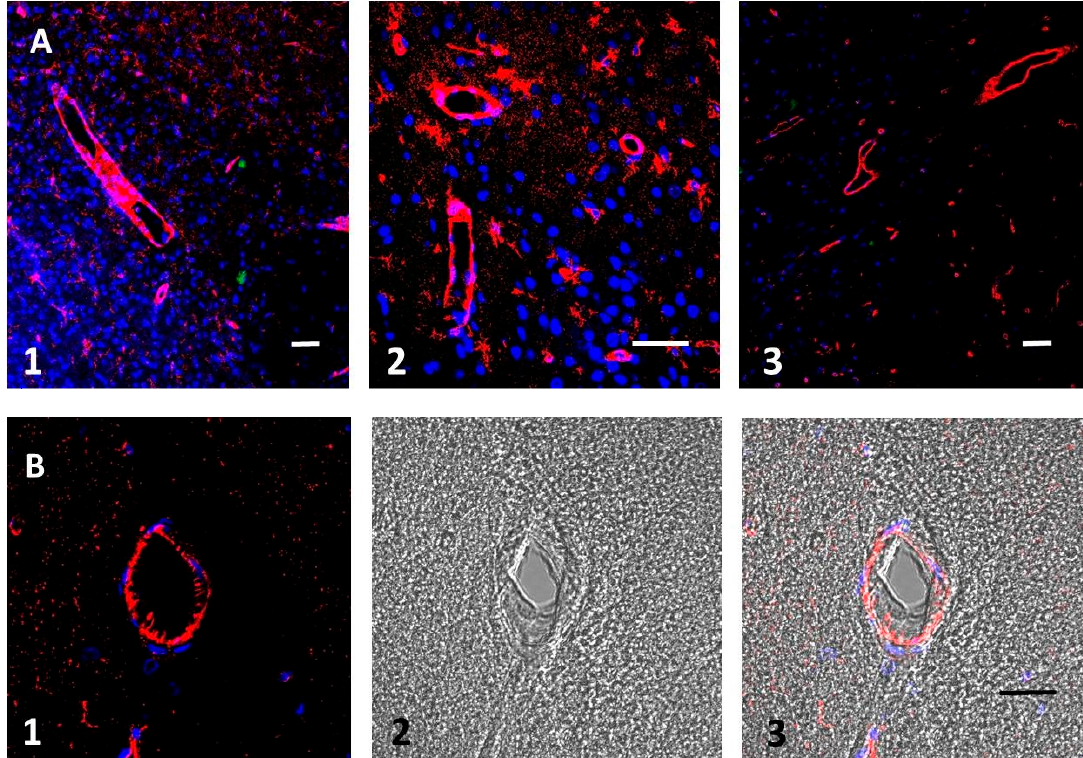
Figure 2. ( A ) Brain zone affected by ischemia. Amyloid beta (A β ) peptide oligomer immunostaining (red), Congo red staining specific for aggregated amyloid (green). The walls of both large and small vessels are visible. Nuclear DAPI staining (blue) shows that A β does not mainly coincide with cells, whereas red staining is mainly present in blood vessels. Congo red staining specific for aggregated amyloid (green) is present as low ‐ density spots in the tissue and not associated with any nucleus. ( B ) Cross ‐ section of a blood vessel in the affected zone after stroke: (1) fluorescence, (2) bright field, (3) merged view. Scale bars, 100 μ m .